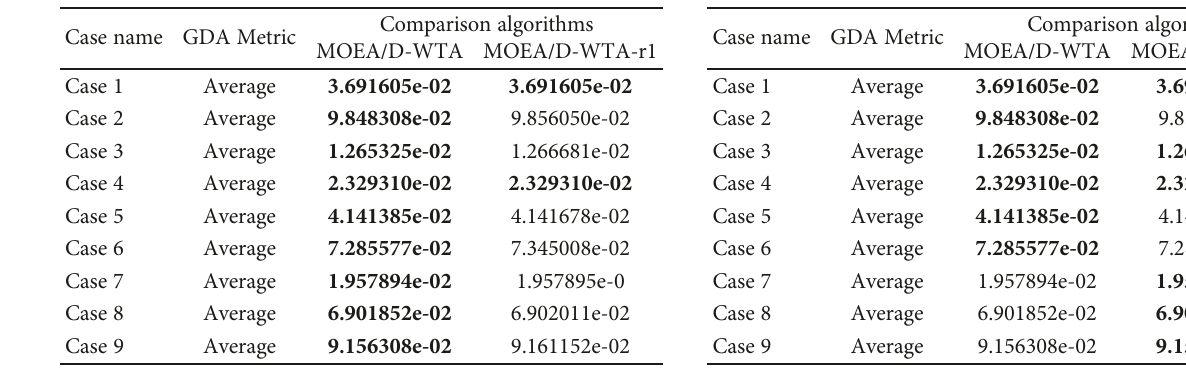
Table 7: Results of the GDA metric for MOEA/D-WTA and MOEA/D-WTA-r2.